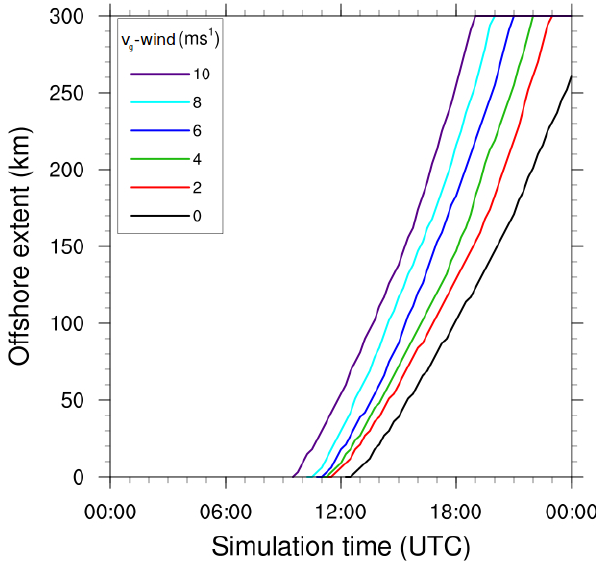
Fig. 14. Sensitivity of the onset time and of the offshore extent of single coast corkscrew sea breezes to the strength of the shore- parallel gradient flow. In all simulations, the YSU PBL scheme and a SST of 287K were